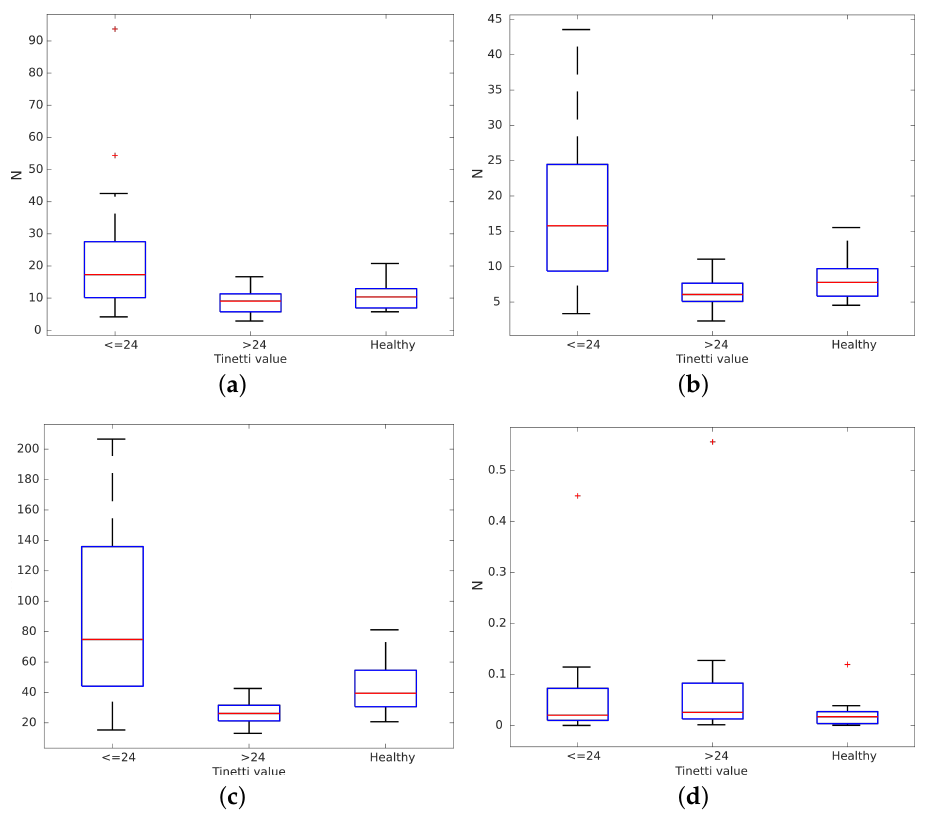
− F right clustered by Tinetti score. Z Z